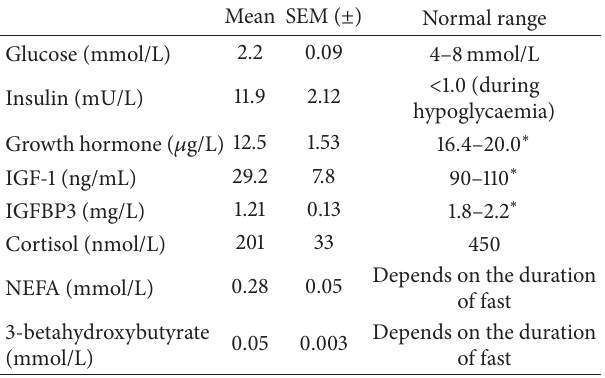
Table 2: Hormone responses in neonates with HH during the episode of hypoglycaemia.